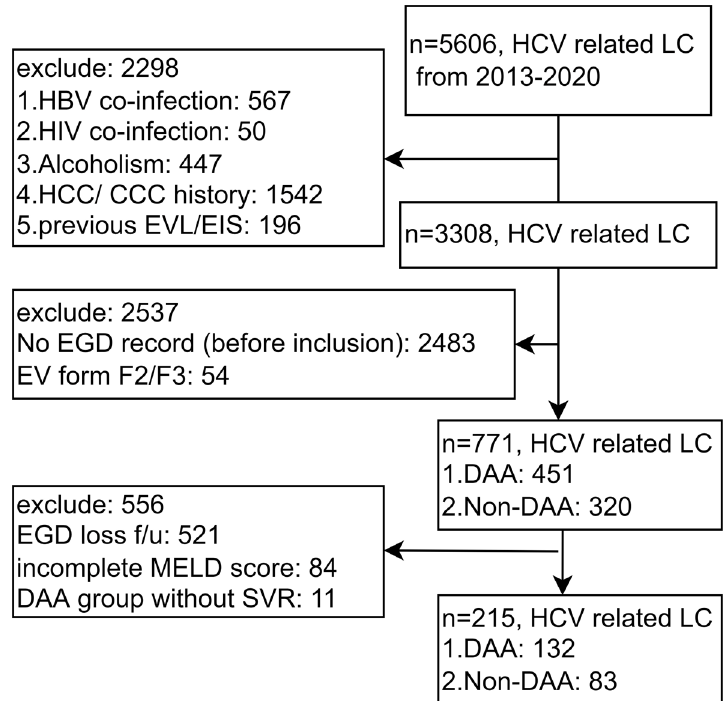
Figure 1. Flowchart of the study. Abbreviations: EGD, esophago-gastro-duodenoscopy; HCV, hepatitis C virus; LC, liver cirrhosis; DAA, direct-acting antivirals; HBV, hepatitis B virus; HIV, human immunodeficiency virus; EVL, esophageal varices ligation, EIS, endoscopic injection sclerotherapy; HCC, hepatocellular carcinoma; CCC, cholangiocarcinoma; f/u follow up; MELD score, Model for End-Stage Liver Disease score; SVR, sustained virologic response.